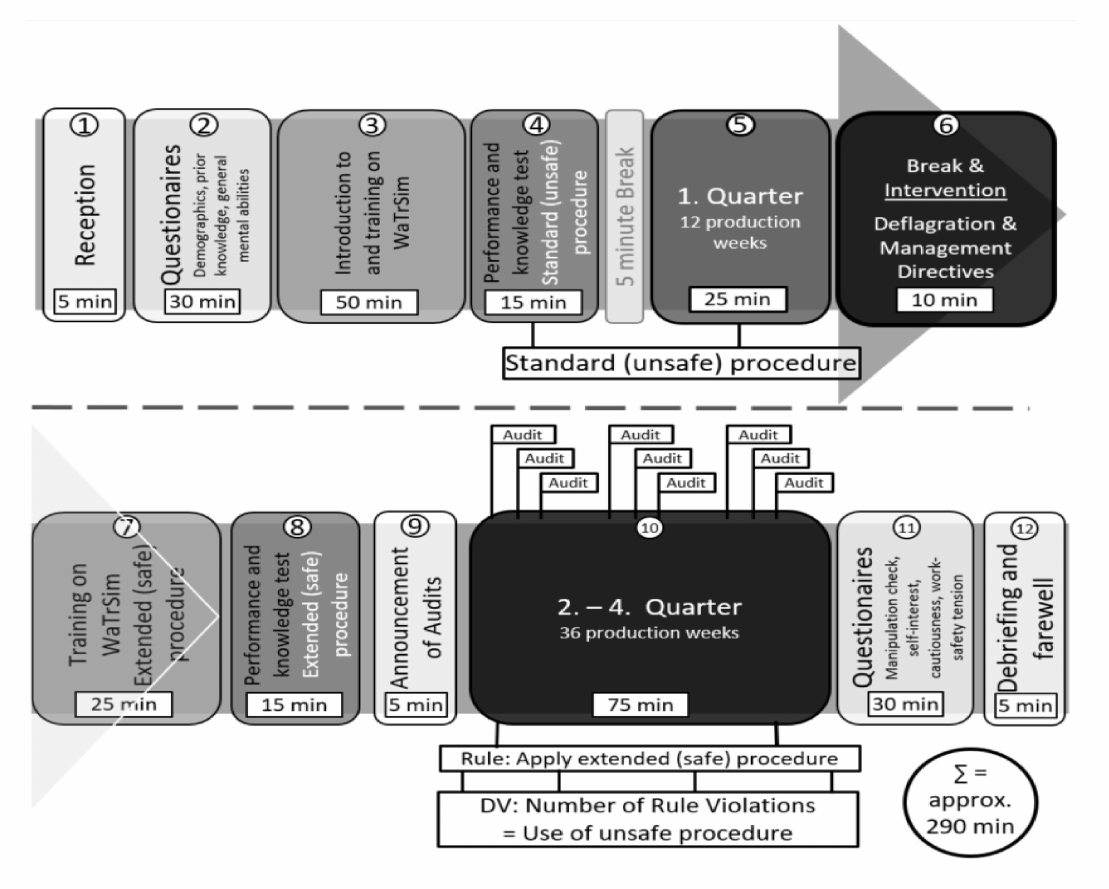
Figure 2. Phases and duration of experimental procedure, measurements taken, trained procedures and measurement of dependent variable of rule